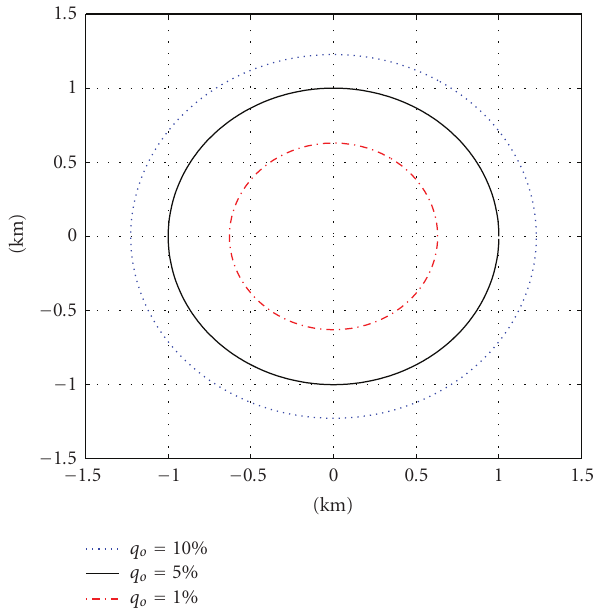
Figure 1: Single cell broadcast